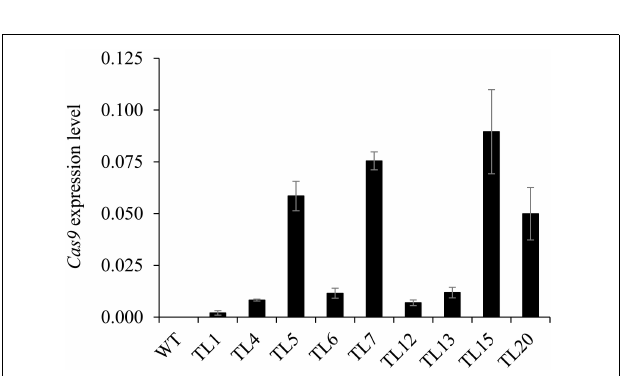
FIGURE 5 | Expression levels of Cas9 in co-transformed hairy root lines. Quantitative real-time PCR analysis of Cas9 expression levels in 1 st generation hairy roots of nine lines. Root samples 10–15 days after inoculation were collected from untransformed wild type roots and co-transformed hairy root lines 1, 4, 5, 6, 7, 12, 13, 15, and 20. M. truncatula Actin (Medtr3g095530.2) was used as the reference for normalization. Value are mean ± SD ( n = 3). WT, untransformed wild type